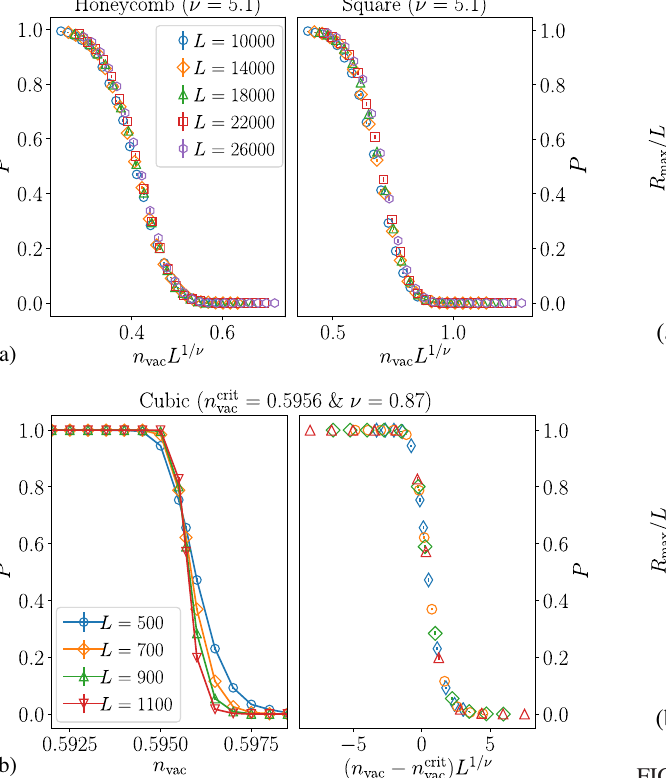
ð n ; L Þ , the sample-averaged radius FIG. 12. (a) Data for R max vac of gyration of the largest R -type region in two-dimensional L × ; L Þ , the probability that a two- FIG. 11. (a) Data for P ð n L samples at various values of n , collapse onto a single scaling vac vac dimensional L × L sample (with periodic boundary conditions =L is plotted as a function of n L 1 = ν for small curve when R max vac and dilution n ) has at least one R -type region that wraps values of n . (b) Left panel: same quantity on three-dimensional vac vac around the torus in at least one direction, collapse onto a single L × L × L cubic lattices, plotted as a function of n . Note that vac scaling curve when data for various L and n are plotted against curves corresponding to different L display a sharp crossing at a vac L 1 = ν for small values of n the scaling variable n . (b) Left ≈ 0 . 6 . (b) Right panel: data for R =L threshold n crit near n vac vac vac max vac panel: plot against n of the corresponding probability P for an from L × L × L cubic lattices collapse onto a single scaling curve vac L × L × L site-diluted cubic lattice. Note that curves correspond- in the vicinity of this threshold when plotted as a function of the ing to different L cross at a threshold n crit in the vicinity of − n crit Þ L 1 = ν . See Sec. VII for scaling variable ð n vac vac vac n ¼ 0 . 6 . (b) Right panel: In the three-dimensional case, data vac ; L Þ collapse onto a single scaling curve for this probability P ð n vac − n crit Þ L 1 = ν for when plotted against the scaling variable ð n vac vac n close to n crit . See Sec. VII for details. vac vac